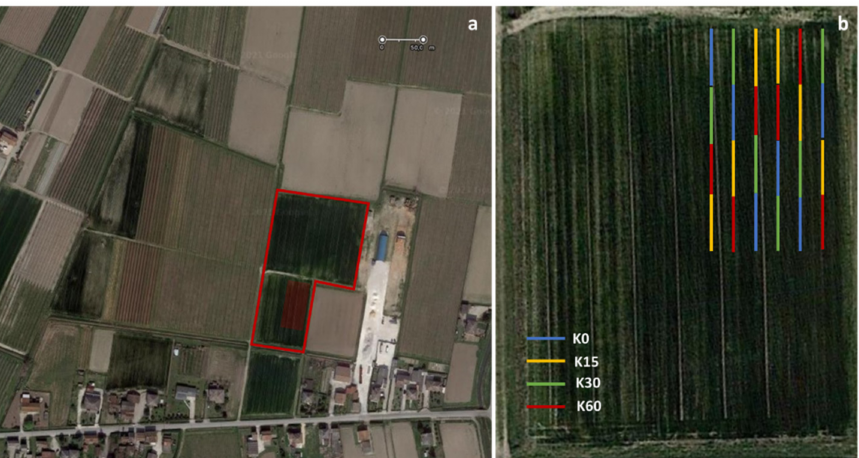
Figure 1. Localization of the vineyard in the study area: the red line indicates the perimeter of the vineyard ( a ). Map of the experimental plots where treatments were applied ( b